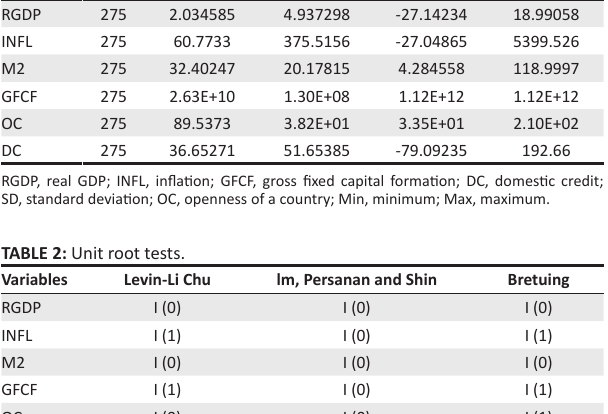
TABLE 1: Descriptive statistics by group. Variable